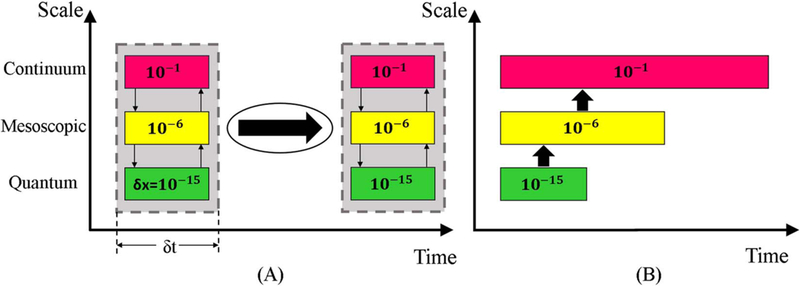
Schematic of multiscale coupling strategies. (A) Concurrent coupling method requires solving all models at the same time step in a parallel mode then moving to the next time step. (B) Sequential coupling method requires solving models over different time lengths sequentially then passing parameters from one model to another.